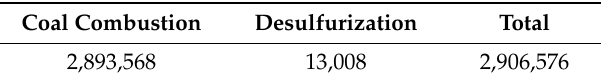
Table 3. CO 2 emissions of one power generation unit